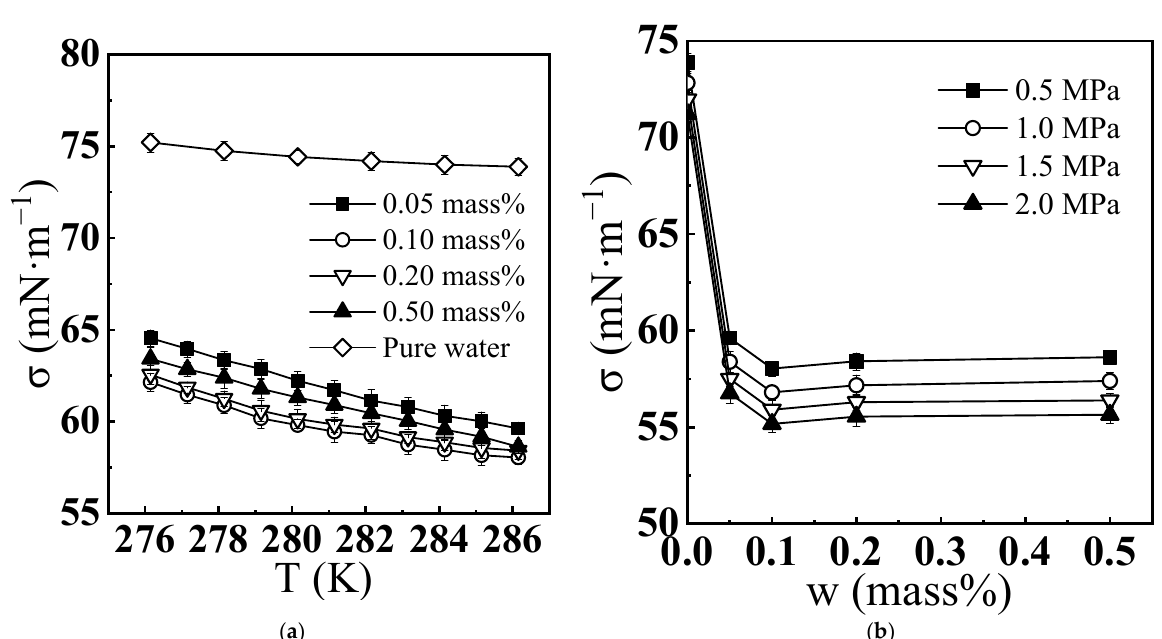
Figure 3. The interfacial tensions ( σ mN·m − 1 ) between ethylene and ( a ) different liquids at different temperatures under 0.5 MPa; ( b ) different liquids under different pressures at 286.15 K.